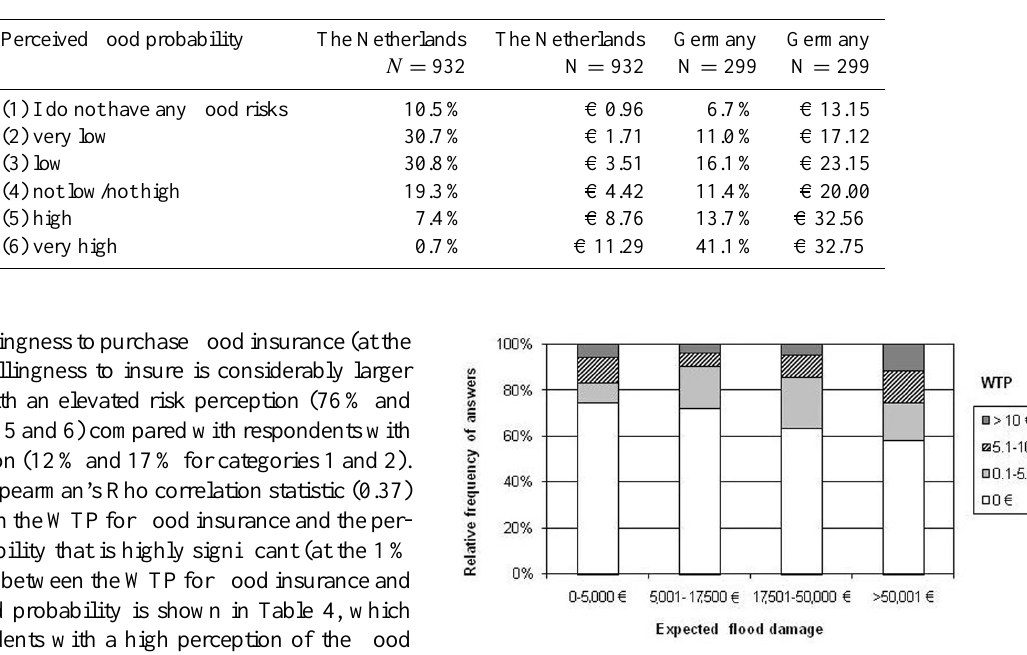
Table 4. Respondents’ perceived flood probability (in % of total respondents) and corresponding mean willingness to pay for flood insurance (in Cper month).